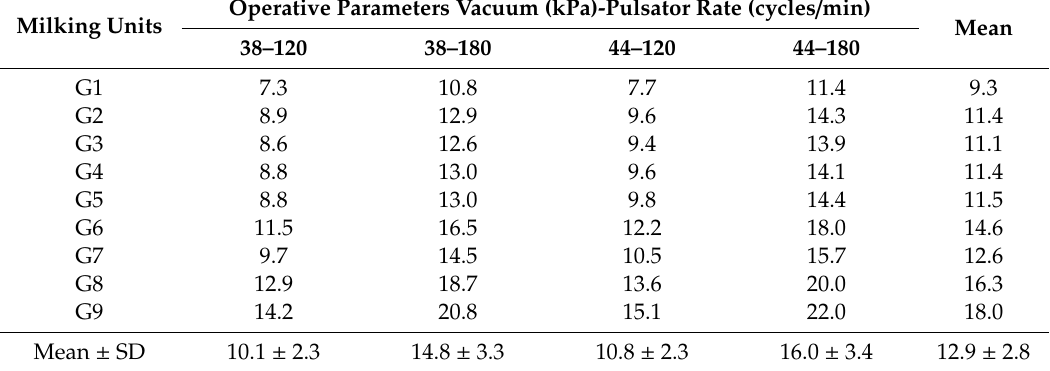
Table 3. Results obtained for each milking unit tested for phase “c” length (%) at di ff erent operative vacuum levels and pulsator rates.